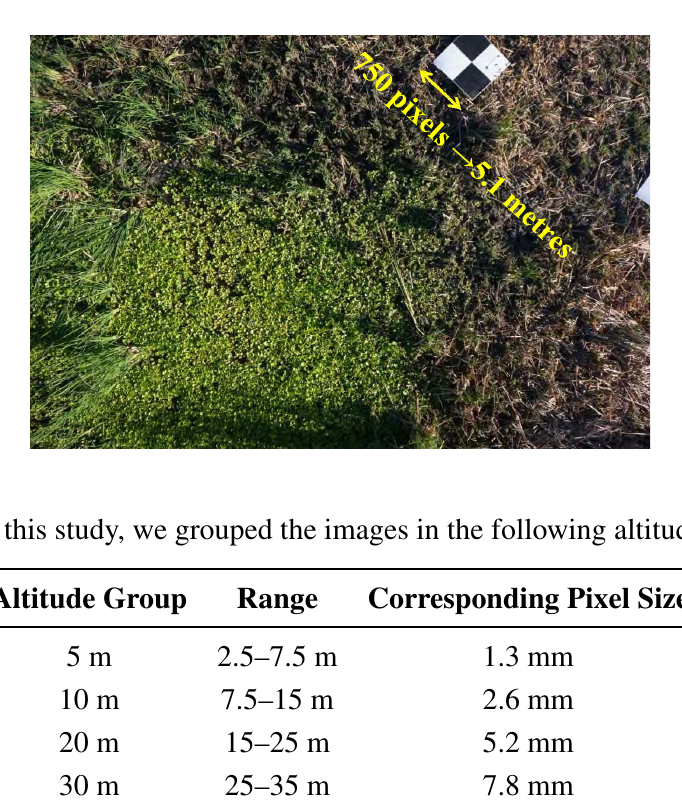
Figure 2. Estimating the altitude of the UAV using the dimensions of a ground control point marker. Knowing the dimensions of the marker and the optical parameters of the camera allowed us to estimate the altitude at which each image was captured.